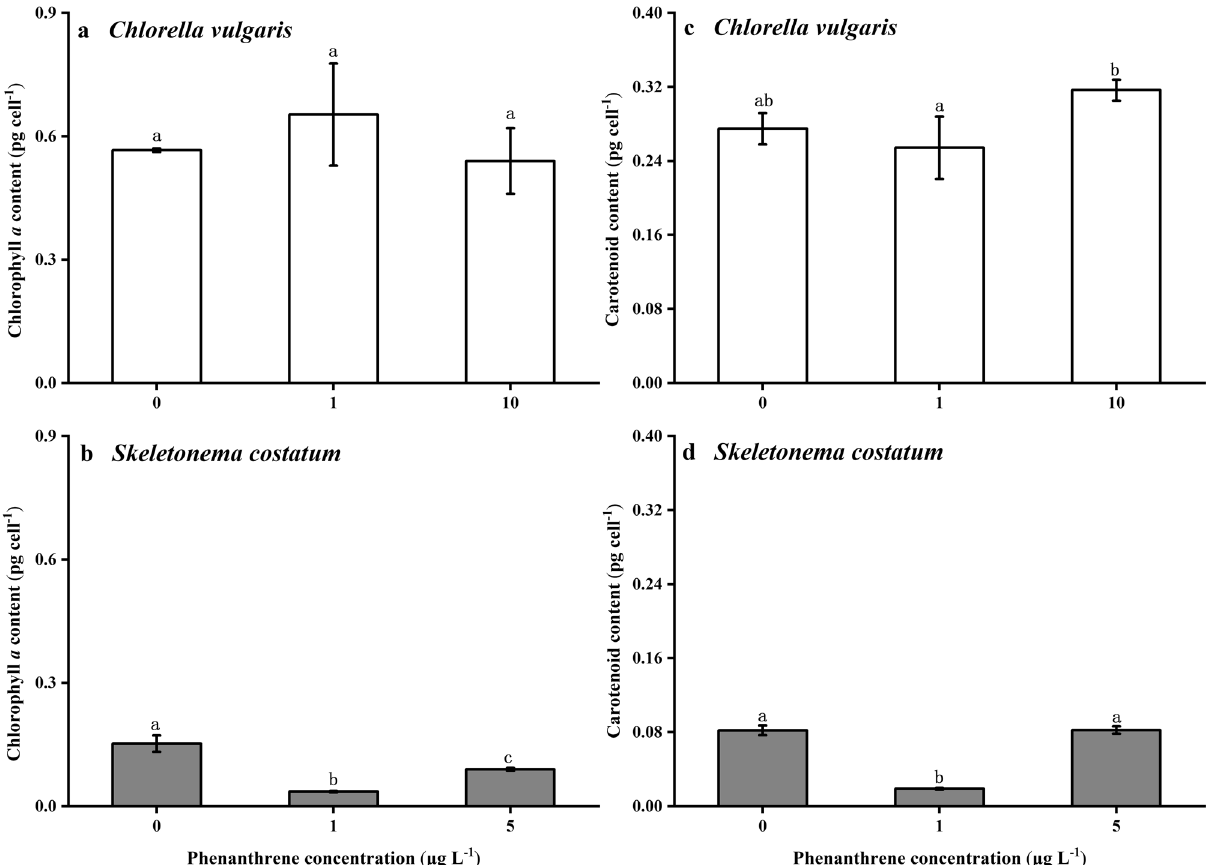
Figure 2. Cellular quotas of chlorophyll a (a,b) and carotenoid content (c,d) (pg cell −1 ) of Chlorella vulgaris (a,c) and Skeletonema costatum (b,d) cells at different phenanthrene concentrations. The data are means ± SD of triplicate cultures (n = 3). The different lowercase letters indicate significant ( p < 0.05) differences between phenanthrene concentrations in one species (one-way ANOVA and post-hoc Tukey threne enhanced the rETR max and α values of S. costatum cells by 26% and 68%, respectively (Table 1). However, S. costatum cells exposed to the high phenanthrene concentration showed decreased rETR max and I k . (Table 1).